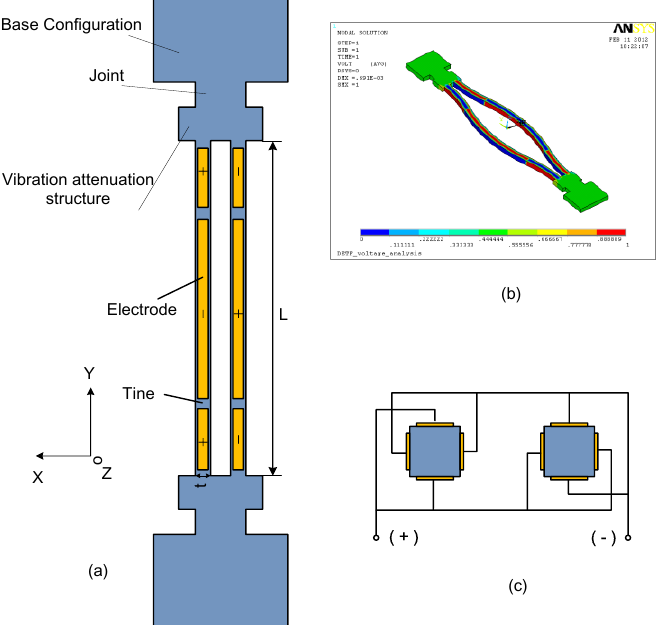
Figure 2. Schematic drawing of ( a ) the quartz crystal DETF resonator with vibration attenuation; ( b ) finite element analysis of the DETF resonator; ( c ) electrodes placed on the DETF